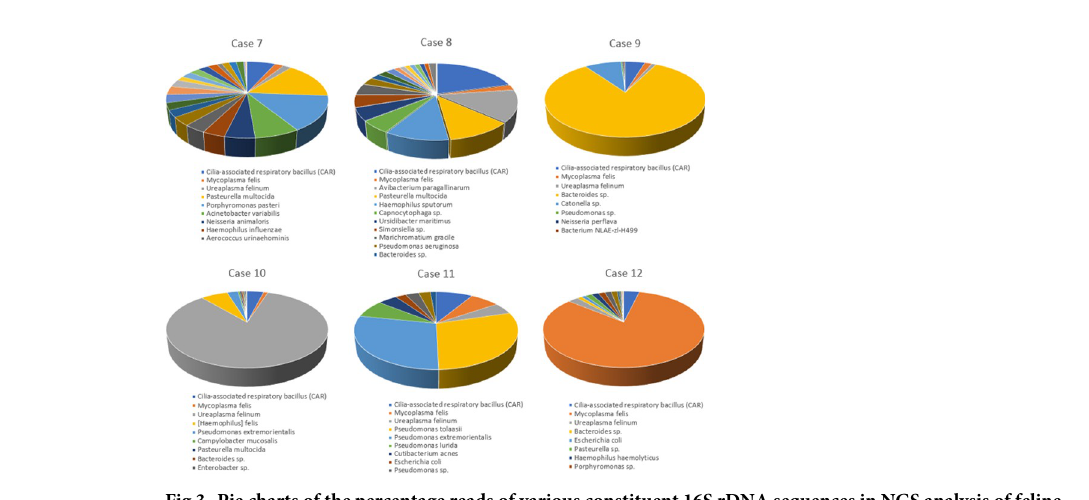
Fig 3. Pie charts of the percentage reads of various constituent 16S rDNA sequences in NGS analysis of feline BALF specimens from cats with lower airway disease and where F . felis was not the preponderant organism. Legend same as for Fig